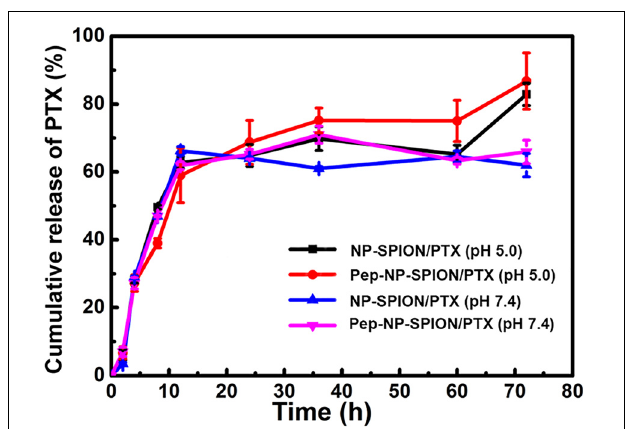
FIGURE 4 | PTX release profiles from NP-SPION/PTX and Pep-NP- SPION/PTX in HAc-NaAc (pH 5.0) and PBS (pH 7.4) buffer solution containing 0.1% (w/v)